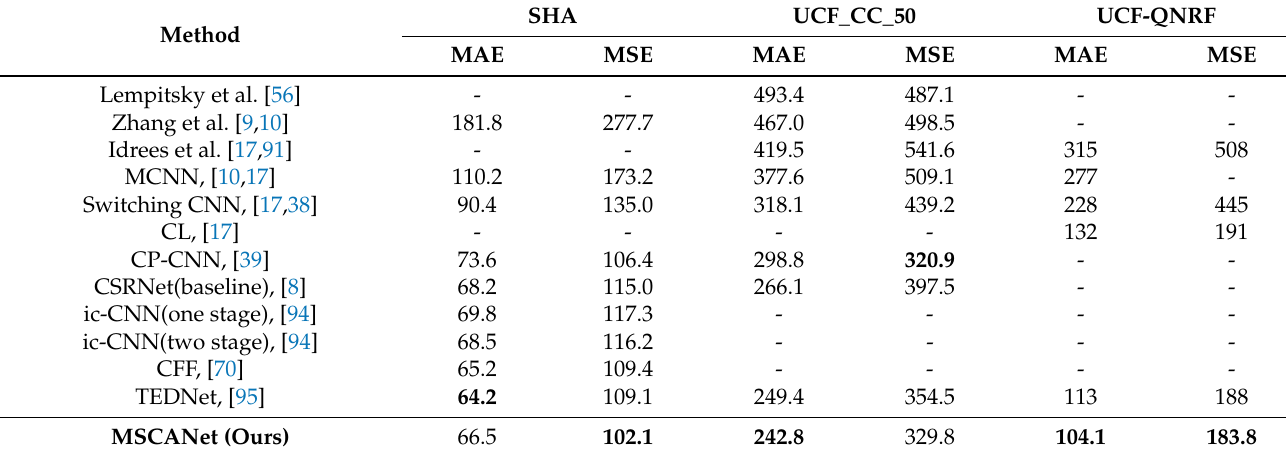
Table 1. Comparison of the different state-of-the-art methods on the ShanghaiTech_Part_A , UCF_CC_50, and UCF-QNRF datasets.